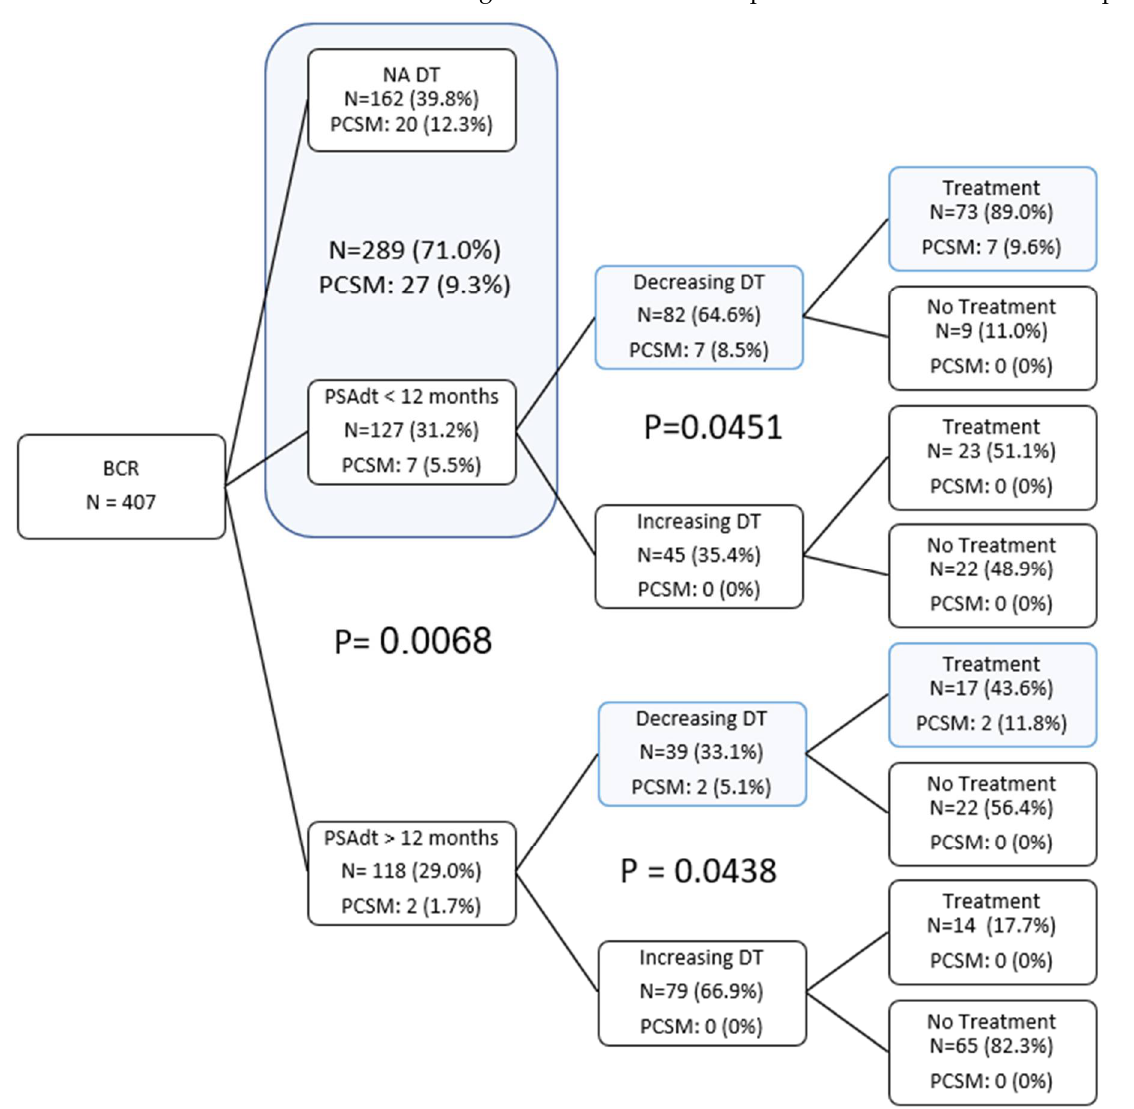
Figure 2. Tree diagram demonstrating PCSM by first initial PSADT after BCR, with the subsequent DT pattern.